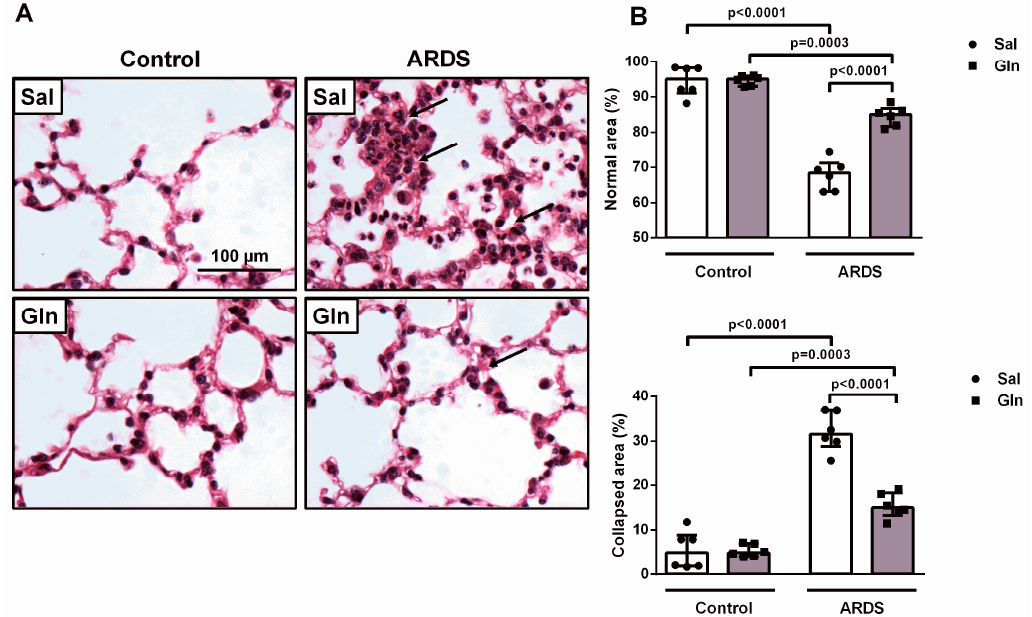
Figure 5. Glutamine administration mitigated histological damage to the lung parenchyma in a mouse model of pulmonary ARDS. At the end of lung mechanics data collection, 24 hours after ARDS induction, animals were sacrificed and the trachea was clamped at the end-expiration (PEEP = 2 cmH 2 O). The right lung was removed, fixed in formalin, and para ffi n-embedded. ( A ) Representative photomicrographs of lung parenchyma were stained with hematoxylin and eosin. Bar = 100 µ m for all photomicrographs. ( B ) Fractional areas of normal and collapsed alveoli, presented as percentage, were determined by the point-counting technique (10 microscopic fields / slide). Values were expressed as the median (interquartile range) of six animals in each group. Symbols represent individual animals. Experiments were performed in triplicate. The data shown are from a single representative experiment.